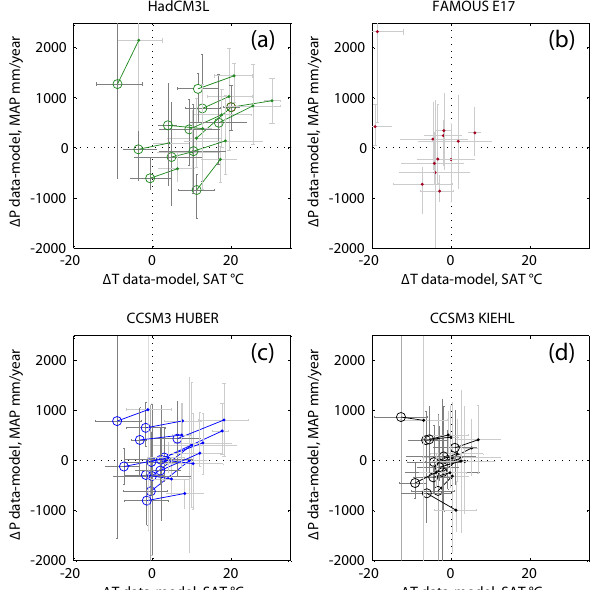
Figure 11. Surface air temperature and mean annual precipitation proxy–model anomalies for low- and high-CO 2 climates shown by closed and open circles respectively. Simulations are at x2 and x6 the CO 2 levels for HadCM3L (a) , E17 for FAMOUS (b) , x2 and x16 the CO 2 for CCSM3 (H) (c) , and x5 and x9 CO 2 for CCSM3 (K) (d) . The data points represent averaged signals for the sites shown in Fig. 10. Estimates of maximum (minimum) error are cal- culated as anomalies between the highest (lowest) data estimate and the lowest (highest) value within the local model grid.